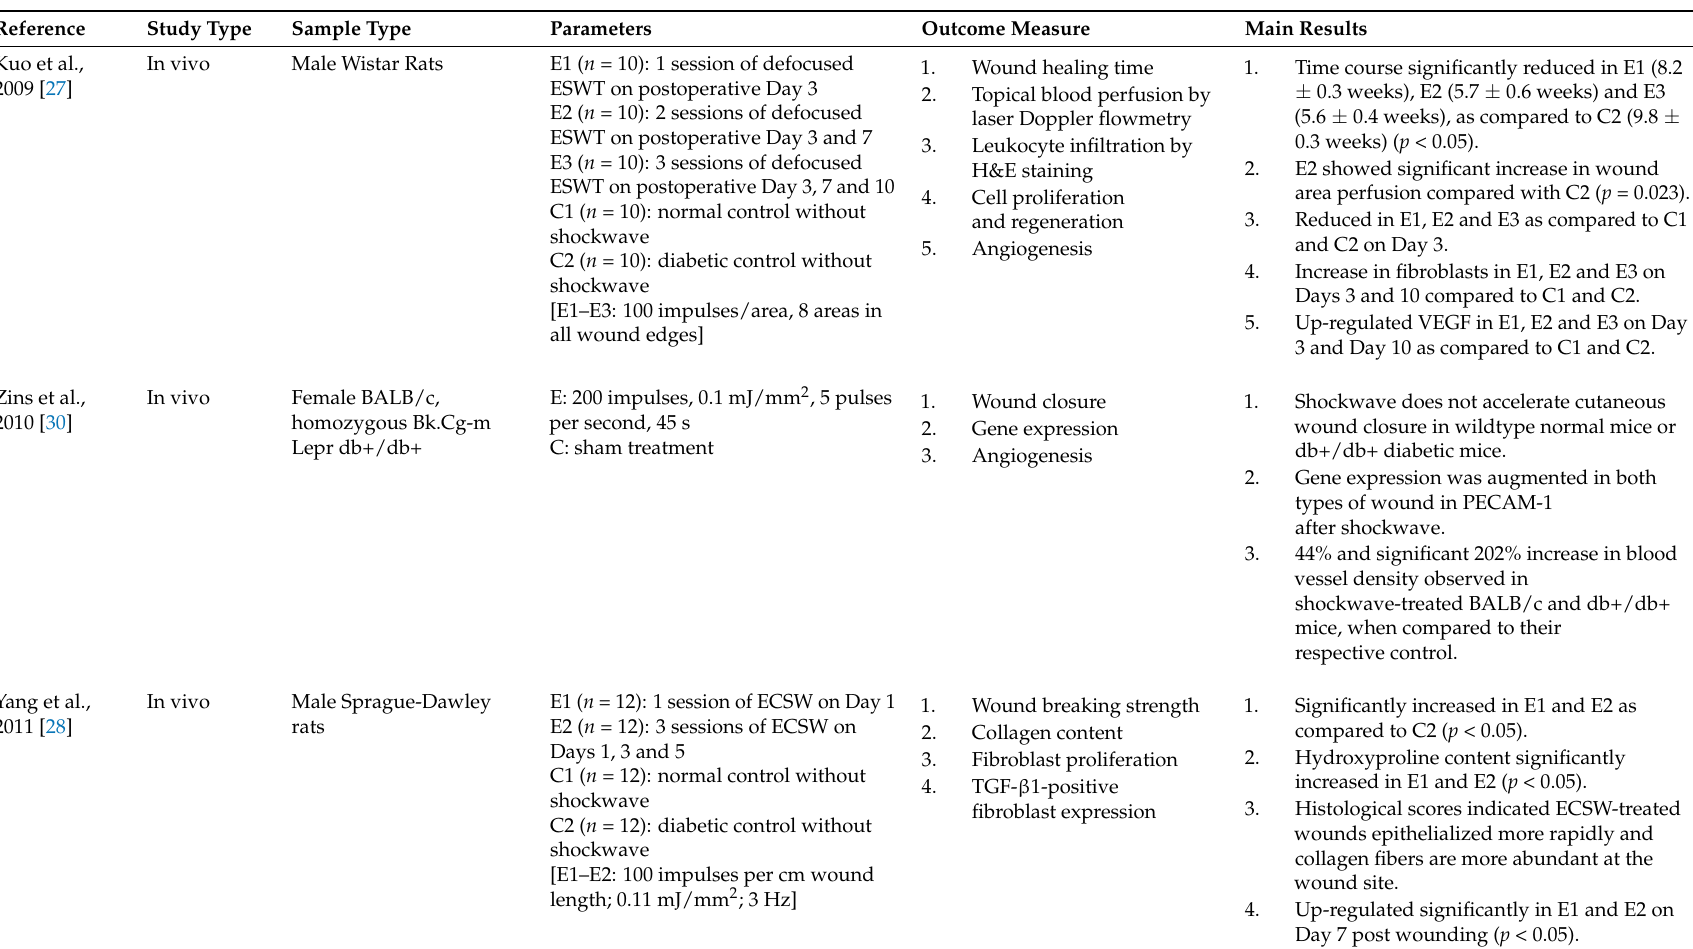
Table 3. Outcomes of ECSW energy for treating diabetic